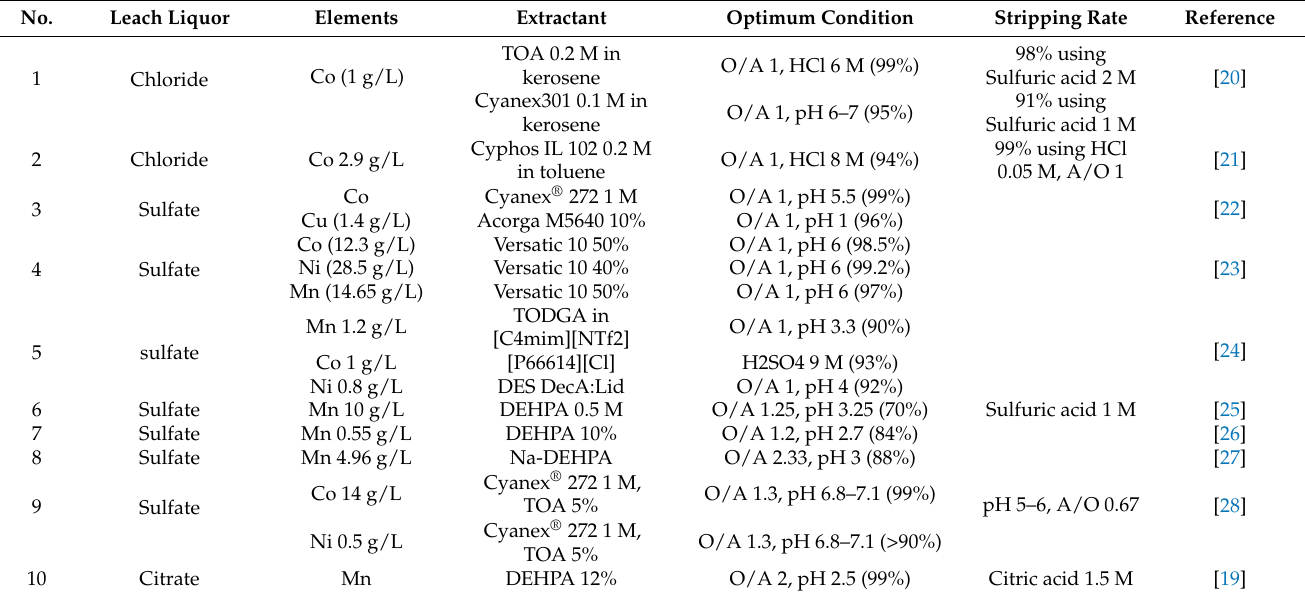
Table 1. Previous investigation on elements separation and purification using solvent extraction from LIB leach liquor.